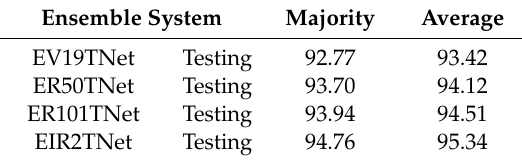
Table 13. Classification performance of ensemble deep models designed by input types.